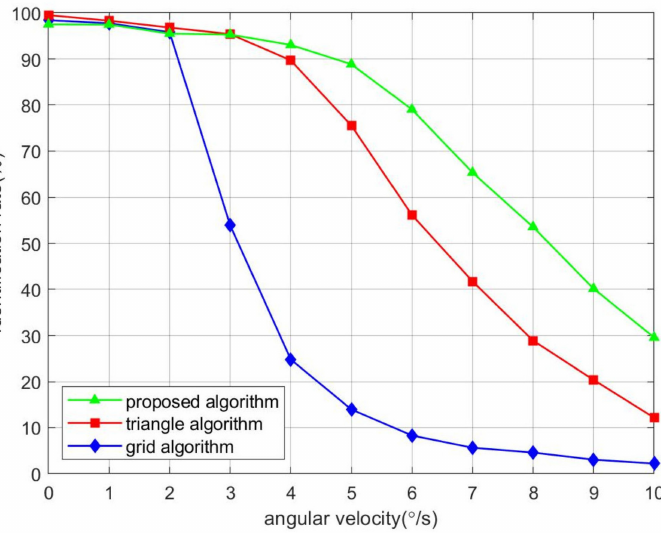
Figure 7. Identification rate for smearing star images at different two-axis resultant angular velocities.